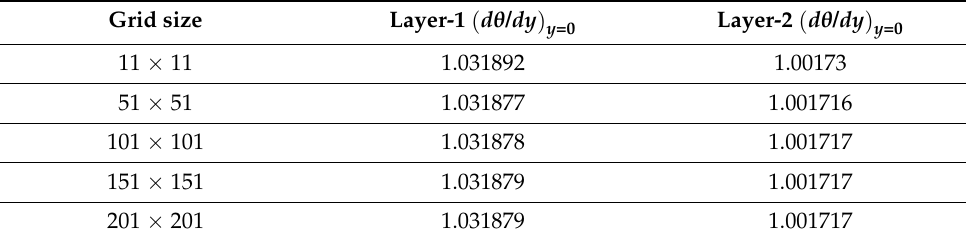
Table 2. To further validate the code, the solutions obtained by Oztop et al. [27], Moshkin [28]